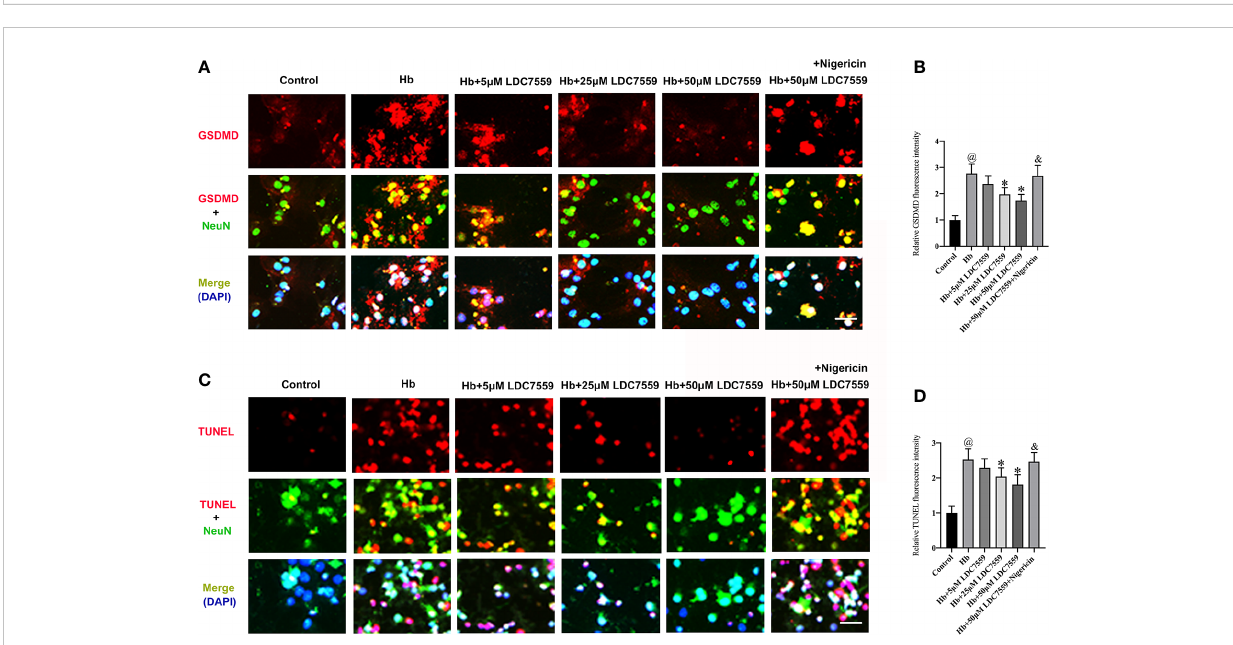
FIGURE 6 LDC7559 reduced neuronal apoptosis and pyroptosis in vitro . Representative immuno fl uorescence microphotographs of GSDMD-positive neurons (A) . Scale bar = 50 m m. Measurement of GSDMD-positive neurons in all groups (B) . Representative immuno fl uorescence microphotographs of TUNEL-positive neurons (C) . Scale bar = 50 m m. Measurement of TUNEL-positive neurons in all groups (D) . Values are presented as the mean ± SD. @ P < 0.05 compared with control group, * P < 0.05 compared with Hb group, & P < 0.05 compared with Hb + 50 m M LDC7559